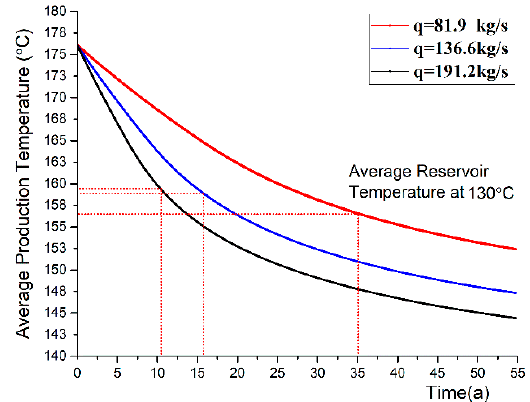
Figure 1 7 . Average reservoir temperature curves of three EGS cases with different injection rates.